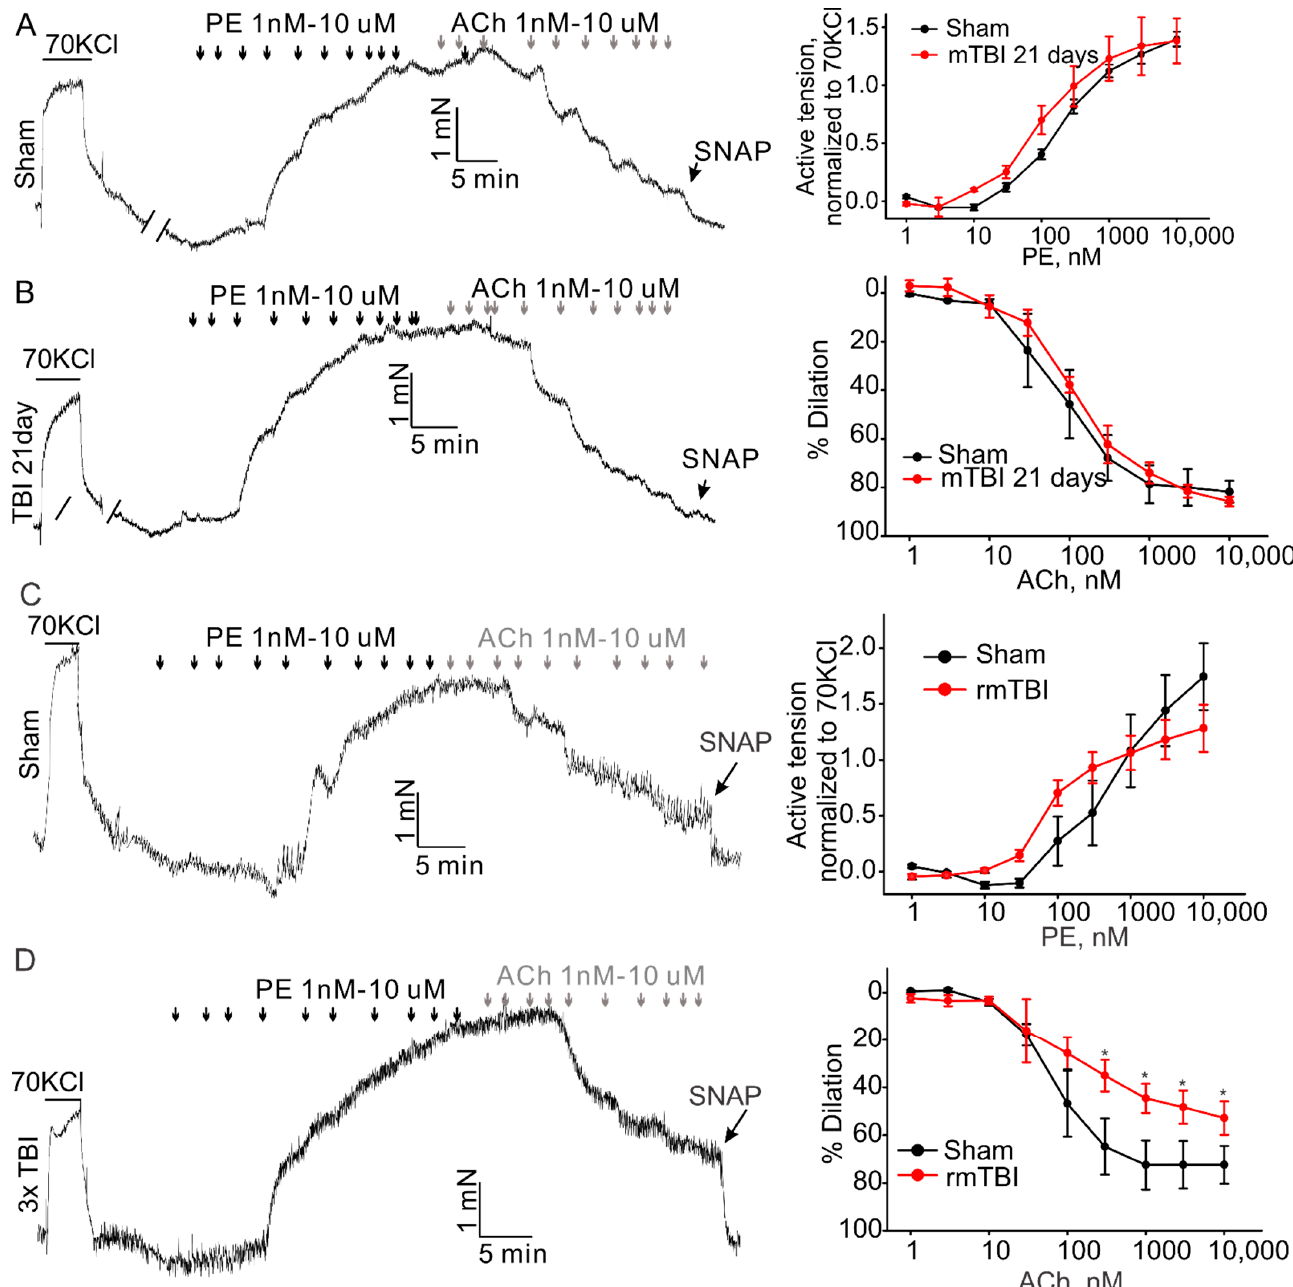
Figure 6. Effect of mTBI or rmTBI on aortic endothelial function 21-day post injury. The left column shows the representative traces of active tension changes in sham ( A , C ) or mTBI ( B , D ) mice in the present of phenylephrine and followed by acetylcholine. The right column shows concentration- response relationships for phenylephrine (PE)-induced contractions and ACh induced dilations. PE-phenylephrine, ACh-acetylcholine. Data are presented as mean ± SEM * p < 0.05 compared to sham.